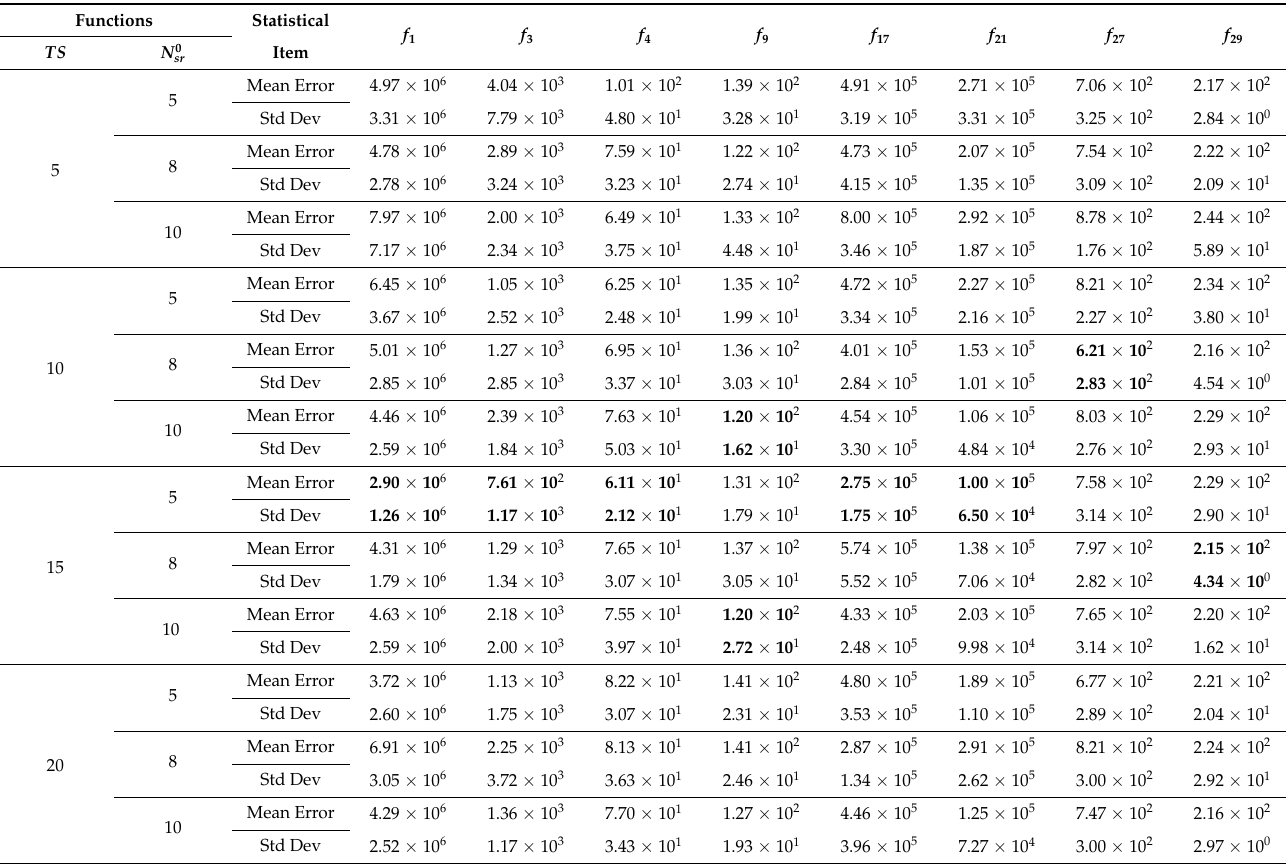
Table 1. Experimental results of the HMWCA with different values for TS and N 0 sr